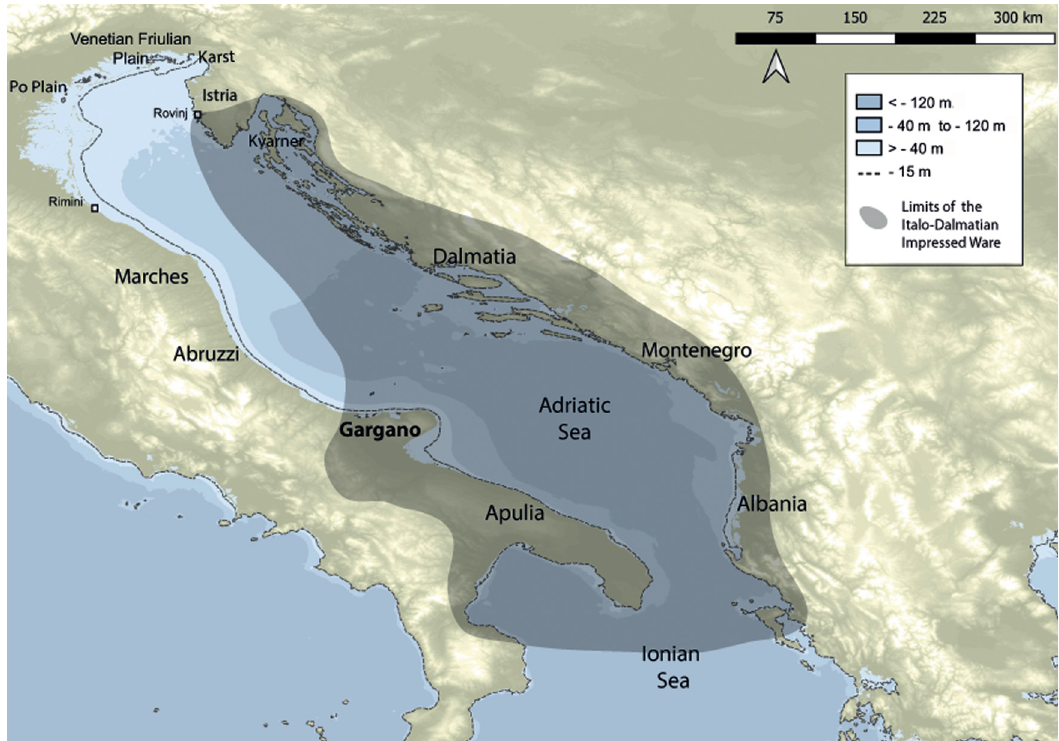
Figure 2: Adriatic region, geographic position of the study area in relation to the post - glacial sea level rise. The − 40 m bathymetric contour ( light blue shading ) depicts the hypothetic position of coastlines at the beginning of the Holocene, while dotted lines indicate the hypothetic position of Early Neolithic coastline ( − 15 m ) . Shaded surface depicts the limits of Italo - Dalmatian Impressed Ware. Background map by Guillaume